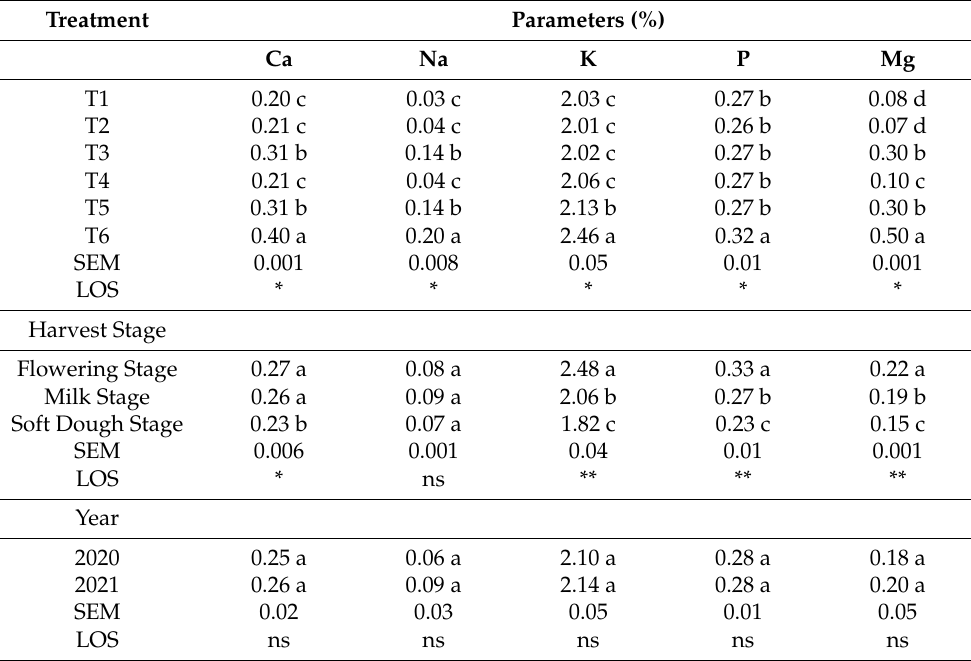
Table 3. Mineral composition of fresh forage of wheat mono-cropping, ryegrass sole cropping, and wheat and ryegrass mixed with alfalfa harvested at different maturity stages